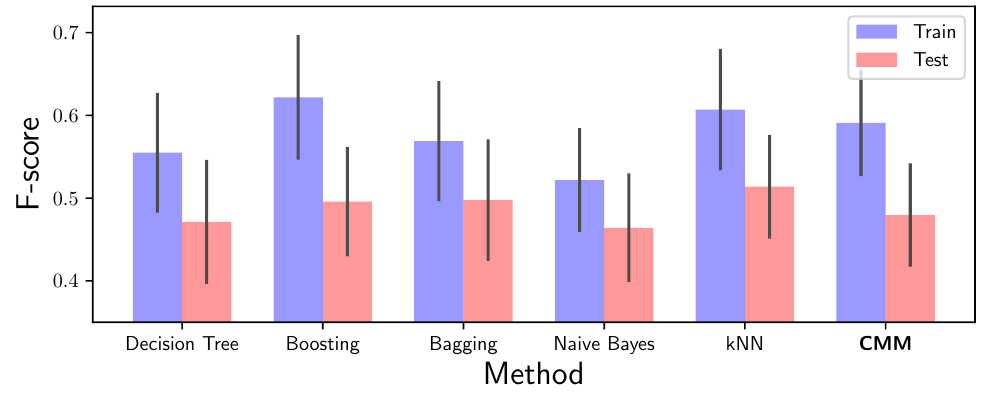
Figure 2. Training and test F-scores of the methods investigated by the creators of the PAMAP2 dataset (leftmost five stacks) along with the approach we are pursuing (rightmost stack). The height of the bars represents the mean F-score, the black lines visualize the standard